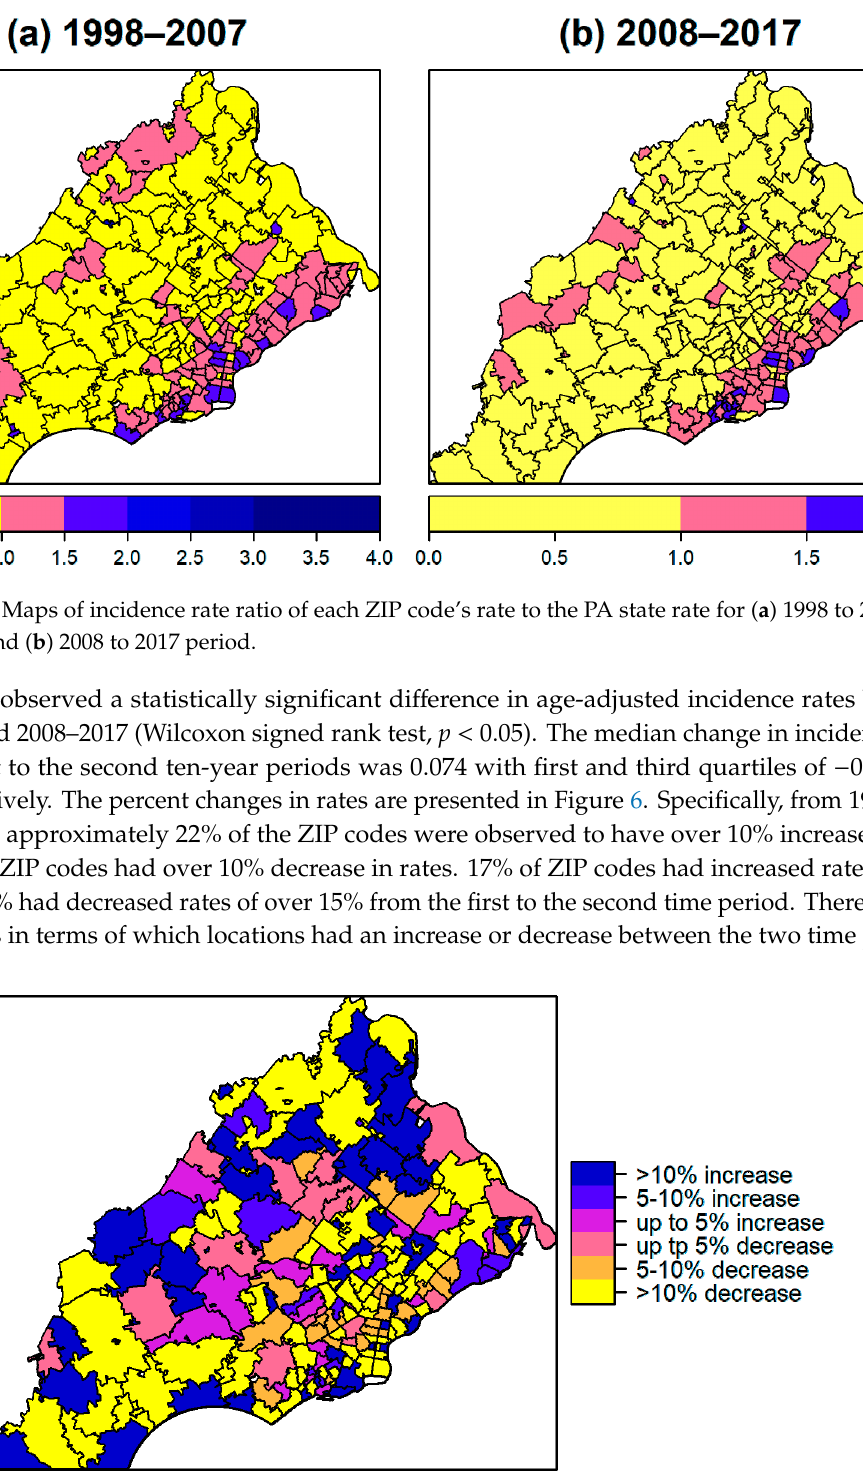
Figure 6. Maps of percentage changes in age-adjusted incidence rate from 1998–2007 period to 2008–2017 period.